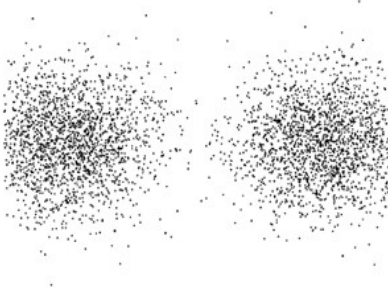
Figure 3. BPSK (SNR = 6 dB). Figure 3. BPSK( SNR = 6 dB) Figure 3. BPSK( SNR = 6 dB)